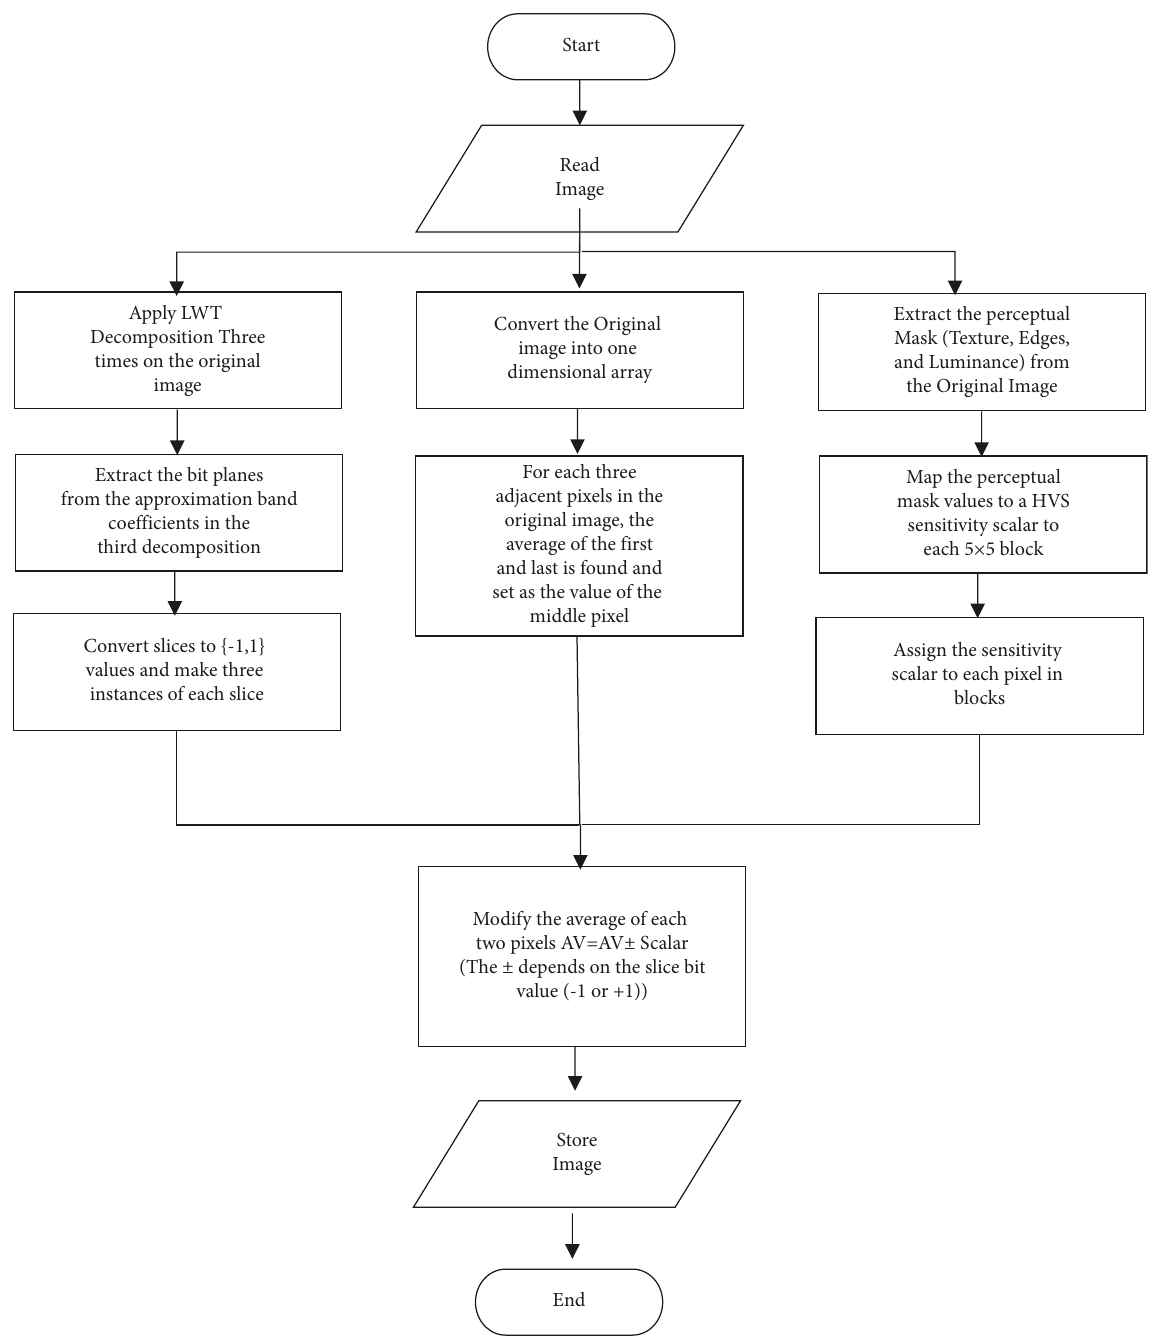
Figure 6: Embedding